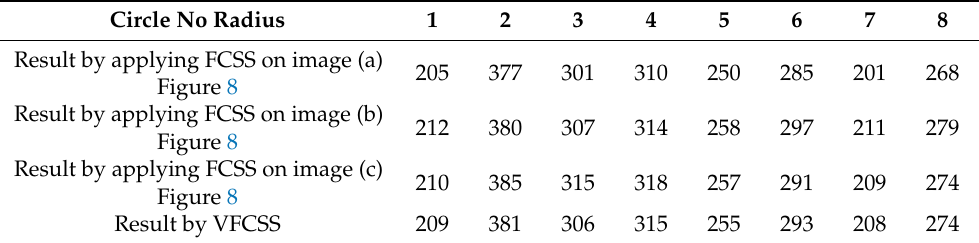
Figure 9. The extracted circles from images (a), (b) and (c) Figure 8 represented by red, green and blue colors, respectively. Table 12. Simulation results for state 4 and comparison of resulting radii with FCSS and VFCSS